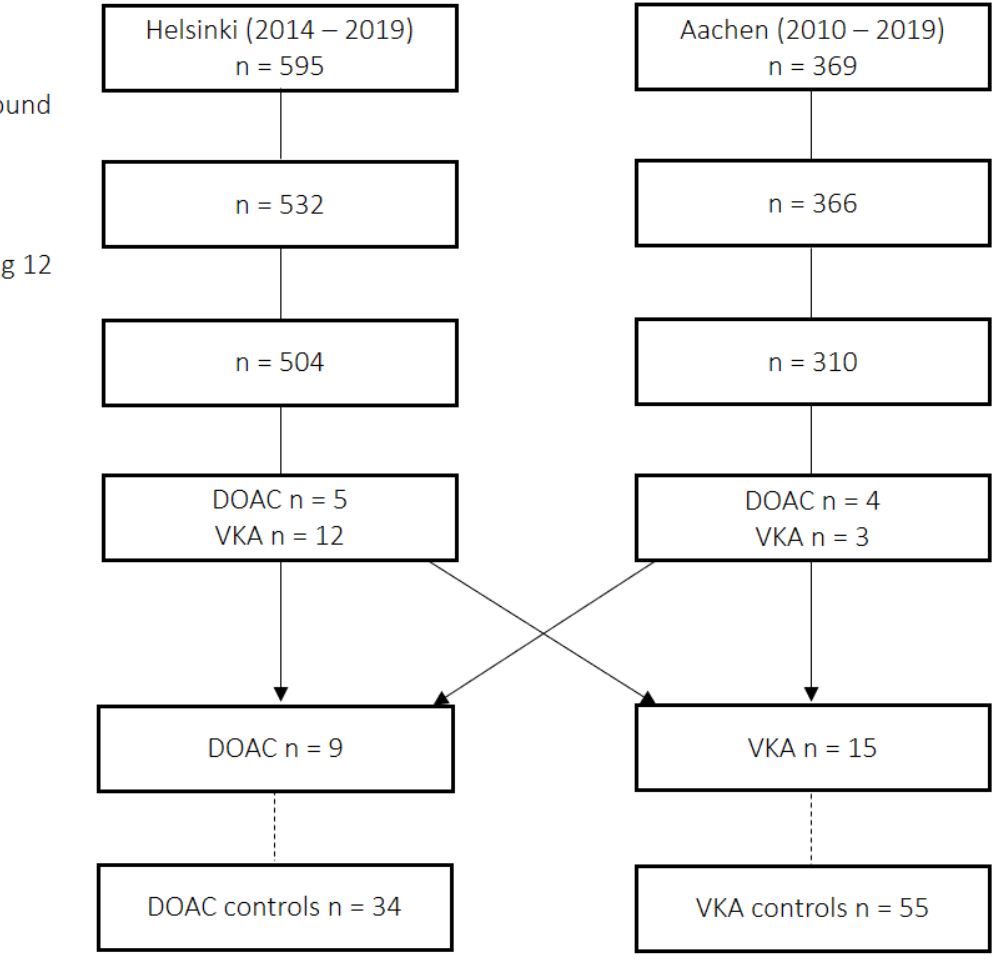
Figure 1. Inclusion flow-chart. DOAC, direct oral anticoagulant; VKA, vitamin K antagonist.